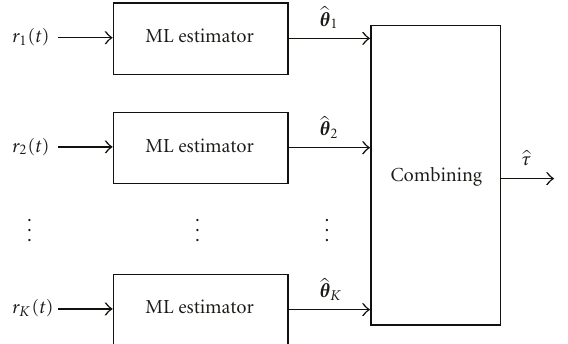
Figure 3: The block diagram of the proposed time-delay estimation approach. The signals r 1 ( t ), ... , r K ( t ) are obtained at the front-end of the receiver as shown in Figure